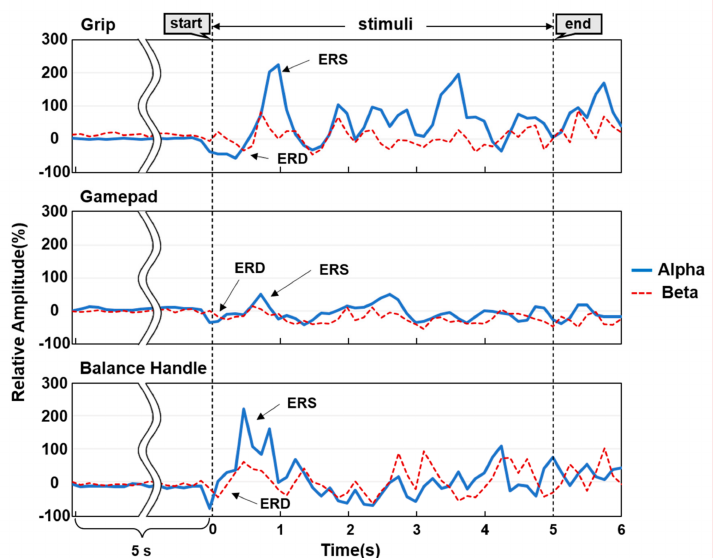
Figure 9. RA measurements with the hand gripping, gamepad operation, and balance handle operation.